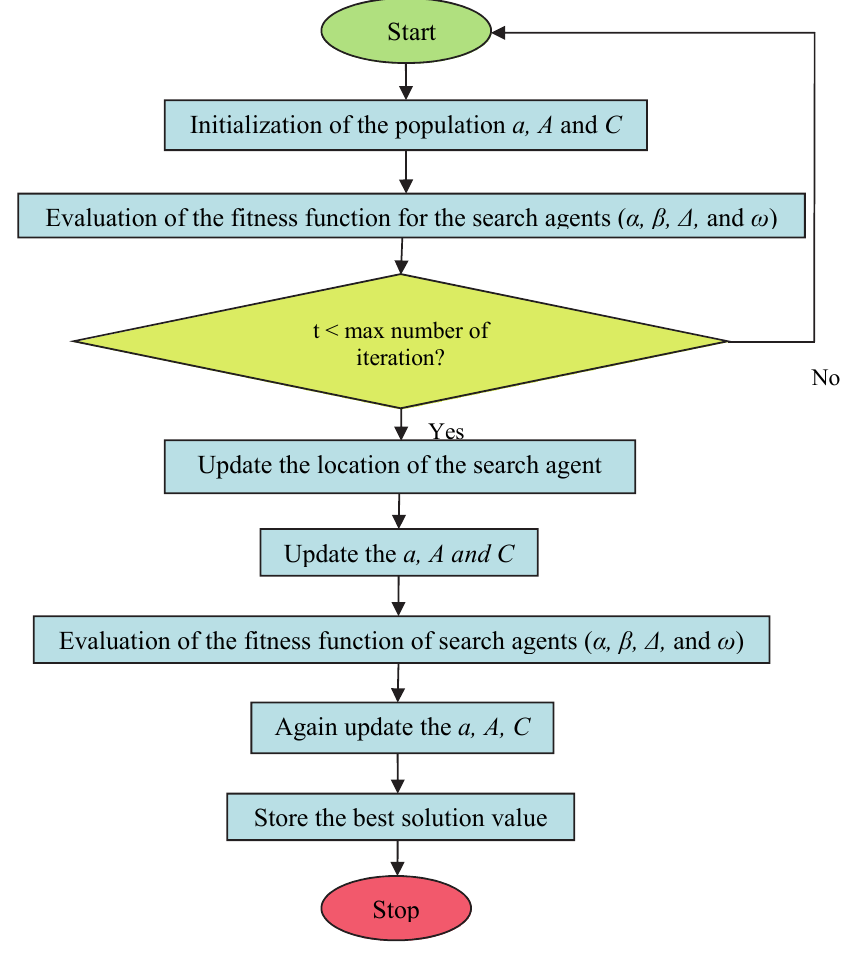
Stop Fig. 1. Flowchart of grey wolf optimization algorithm